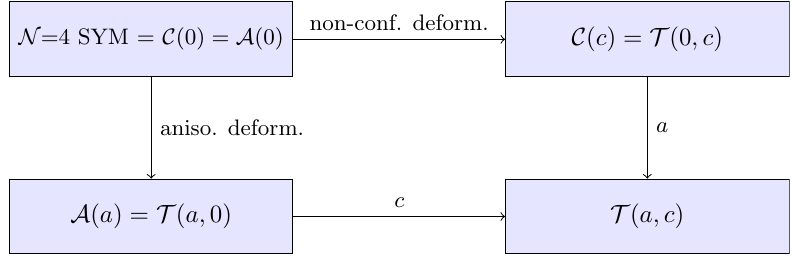
Figure 2 . Scheme of the two-parameter deformation we seek. deformation with deformation parameter a and SYM theory with parameter c .